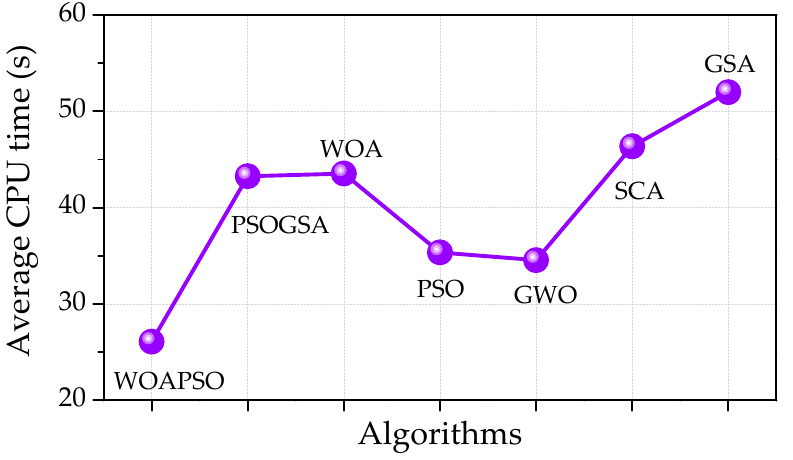
Figure 9. Comparison of the execution time.